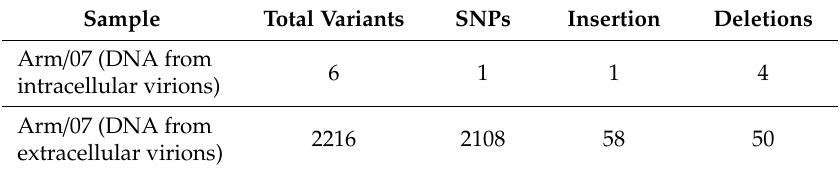
Table 2. Variant analysis of DNA samples of ASFV Arm / 07 from intra- or extracellular virions compared to the Georgia 2007 / 1 reference